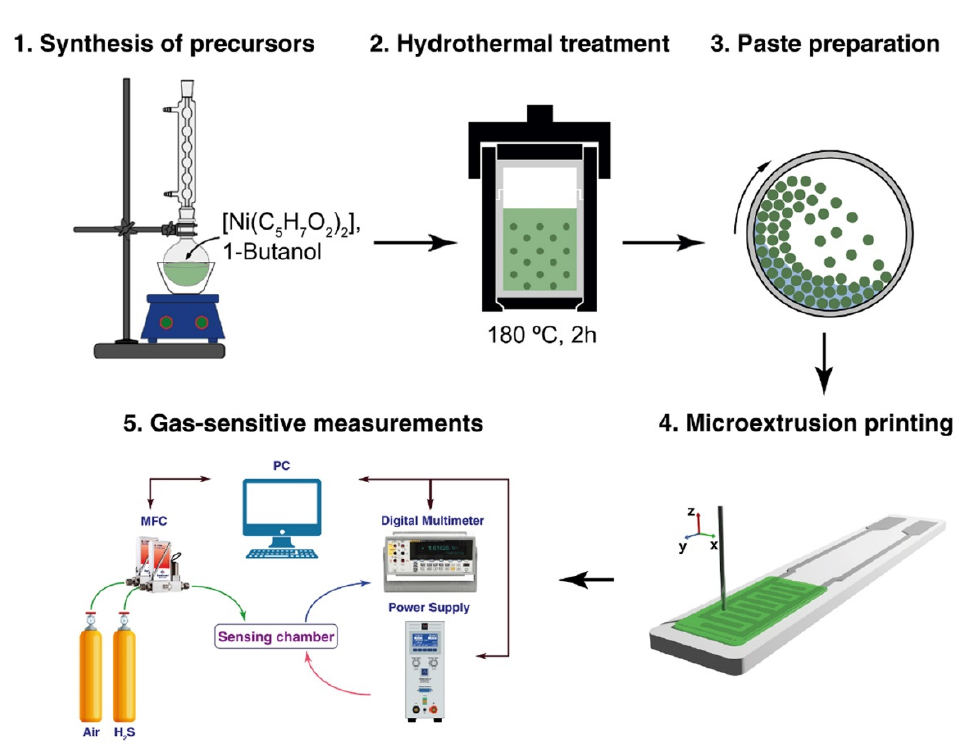
Figure 5. Scheme of hydrothermal synthesis of anisotropic NiO nanostructures and preparation of the ink on their basis that are used for the microextrusion printing of oxide receptor layers. Reproduced from ref. [88]. Copyright 2021, Elsevier, Ltd.